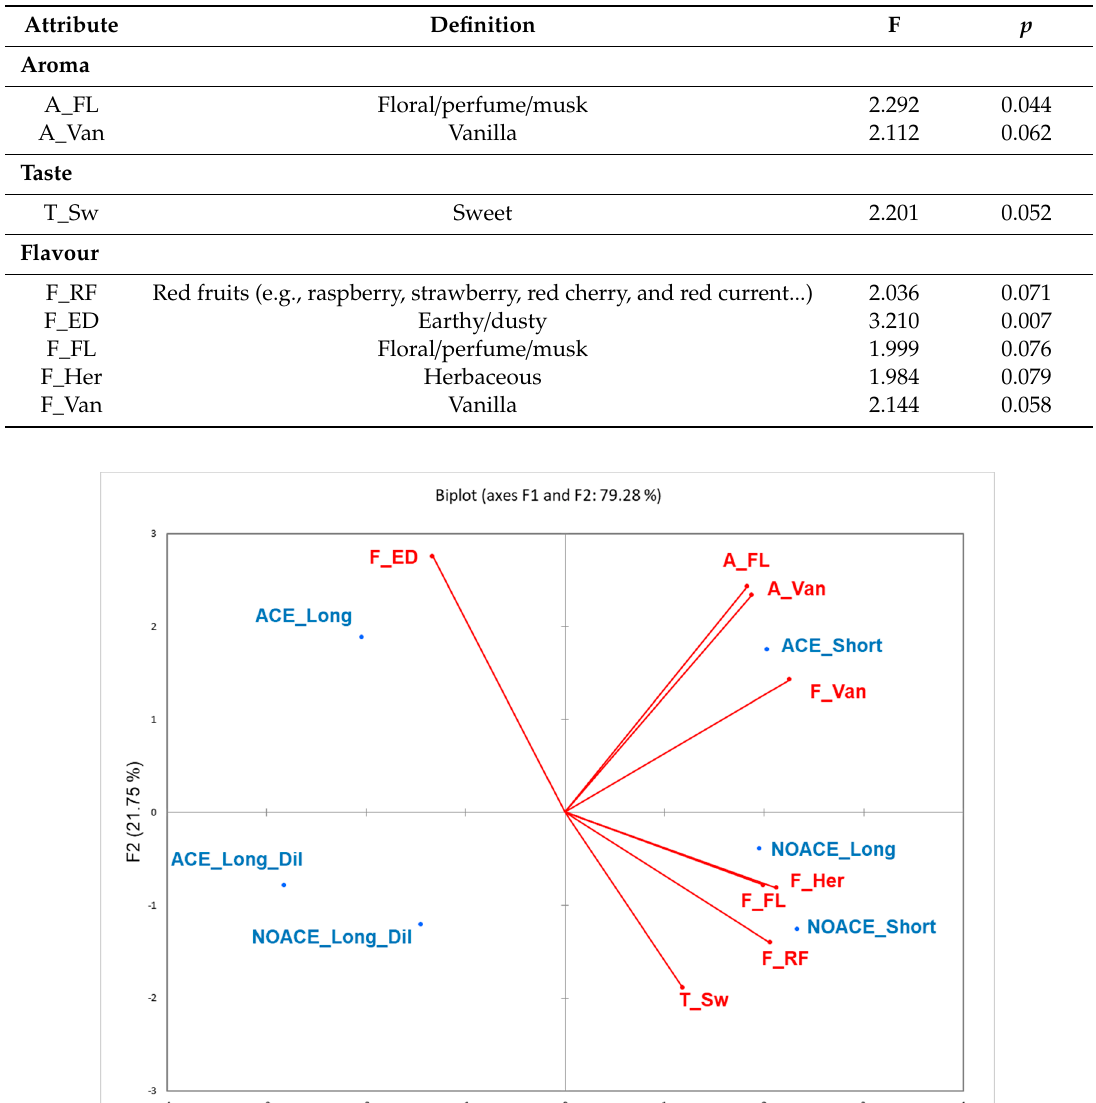
Table 5. The significantly di ff erent attributes across the treatments from rate-all-that-apply (RATA) detected by a multivariate ANOVA (at α 10%).